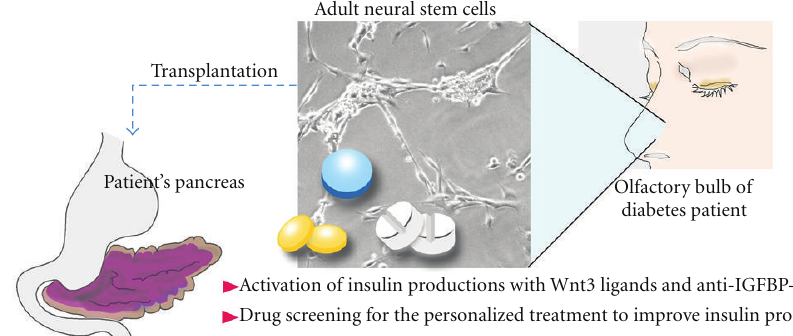
Figure 2: Concept of regenerative therapy for diabetes using autologous neural stem cells from the olfactory bulb. Adult neural stem cells are extracted form the olfactory bulb surgically using an endoscope. Since neural stem cells in diabetic animals had been found to contain higher IGFBP-4 (the Wnt inhibitor) and lower levels of Wnt3 (activators for insulin production via the NeuroD activation) than wild-type animals, treating the cultured neural stem cells with Wnt3 ligands and anti-IGFBP-4 (neutralizing antibody against the IGFBP-4 protein) rescues insulin expressions during ex vivo culture on the collagen sheets. This step would be improved by the various types of drug screening and/or also for order-made cell screening system for the personalized